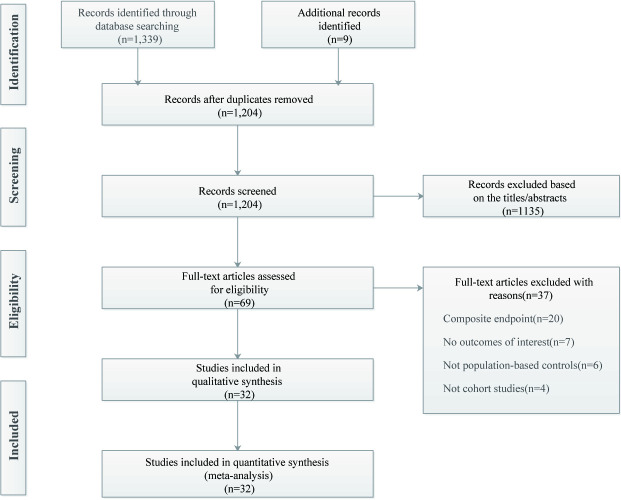
Flowchart of study selection for the meta-analysis (according to PRISMA statement).